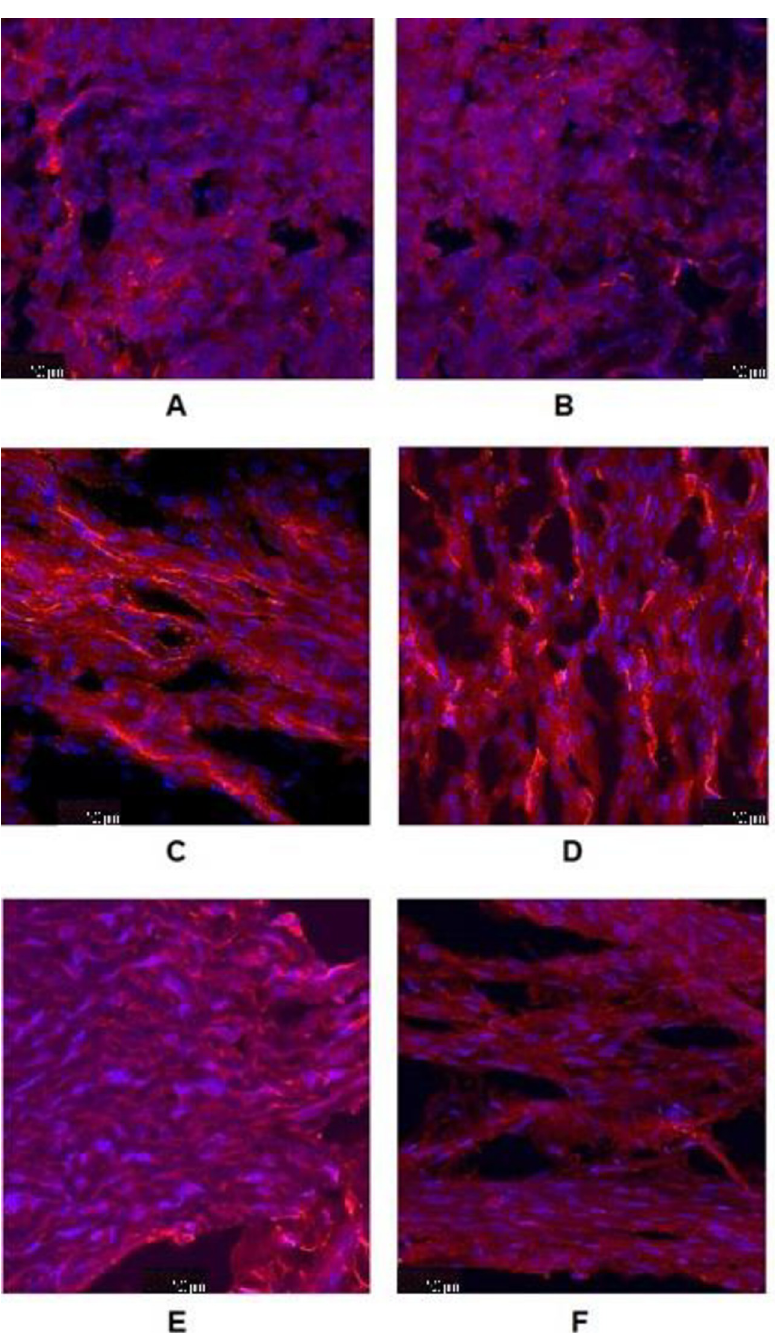
Fig 1. Immunofluorescent staining with antibodies to CD34 (red fluorescence), Hoechst nuclear stain (blue fluorescence), х 400. A—CD34 expression in the medulla of infants in the control group; B—CD34 expression in the medulla of infants with SIDS, C—CD34 expression in the cardiac tissue of infants in the control group, C—CD34 expression in the cardiac tissue of infants with SIDS, E—CD34 expression in the aorta of infants in the control group, F —CD34 expression in the aorta of infants with